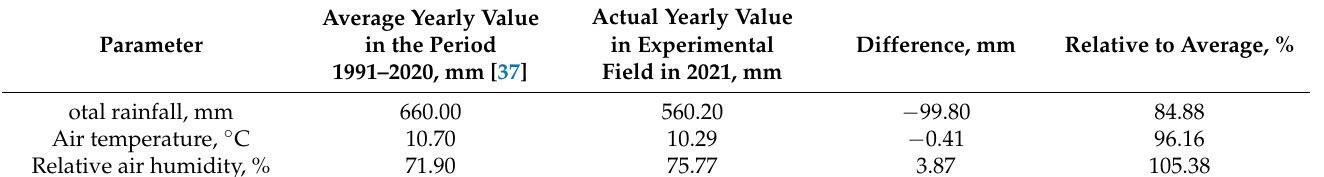
Table 1. Climate parameters of the study area in 2021, compared to the long-term average values.